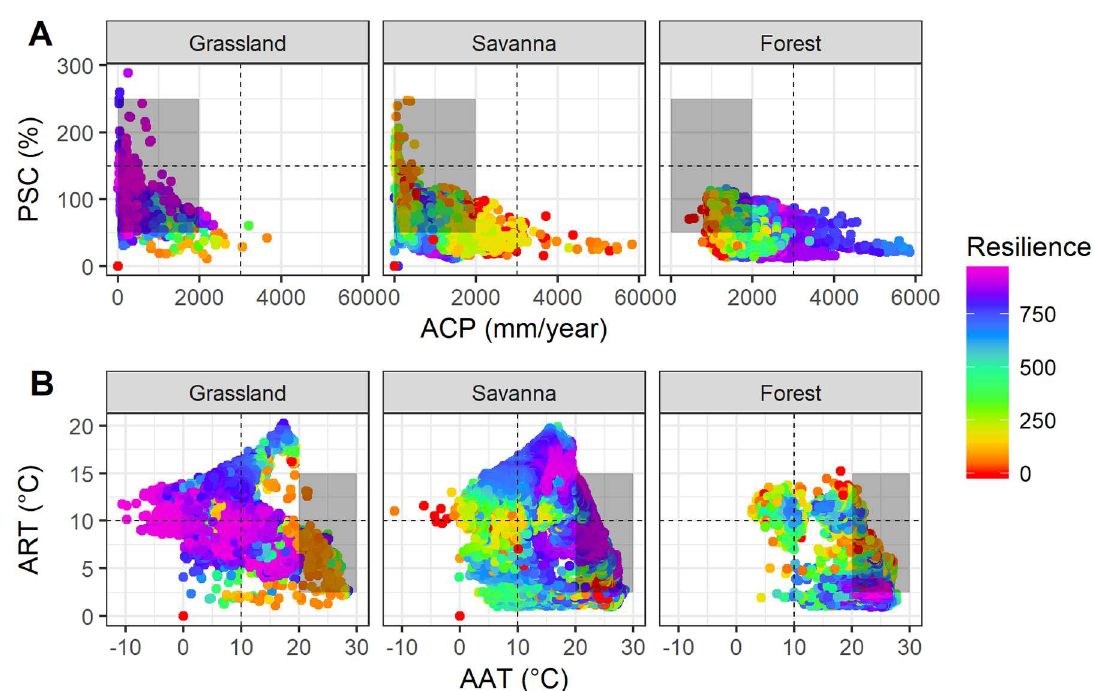
Fig 3. Observed patterns between climatic variation and ecosystem resilience. In the two-dimensional gradient of moisture availability (A) and energy availability gradient (B), if ecosystems are exposed to non-analogous climatic conditions (gray polygon), it is possible to assess what the impacts would be and whether they are likely to adapt to climate change. Forest observations: n = 14,466 samples—38.30%; Savana: n = 19,923 samples- 52.75%; Grassland: n = 3,374